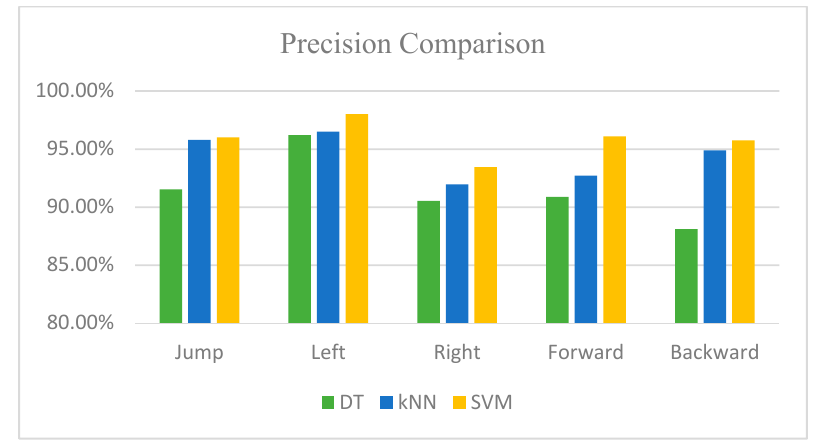
Figure 13. Precision comparison of three classifiers. Table 7. Foot motion identification error of SVM.